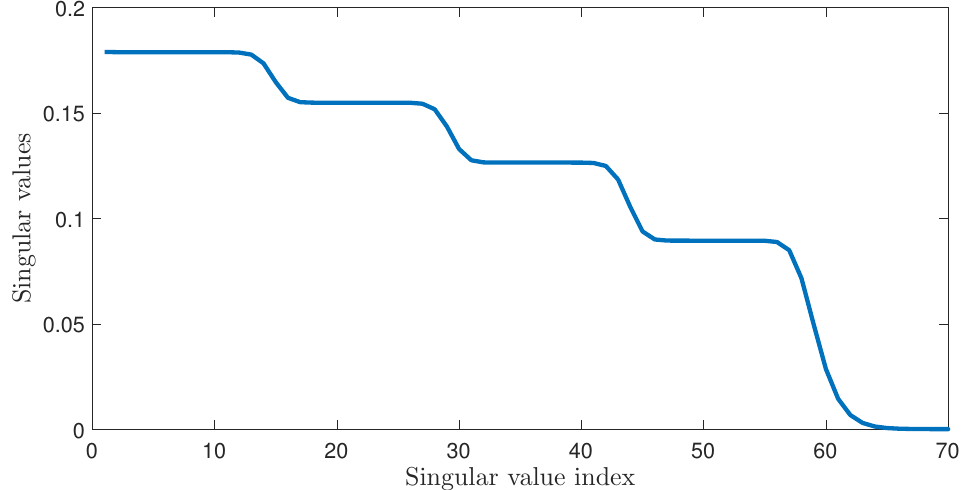
Figure 4. Singular values behaviour of A i for M = 5 views (the other parameters are setted as in Figure 2). The foreseen values for the σ n s on each step are 0.1789, 0.1549, 0.1265 and 0.0894, while